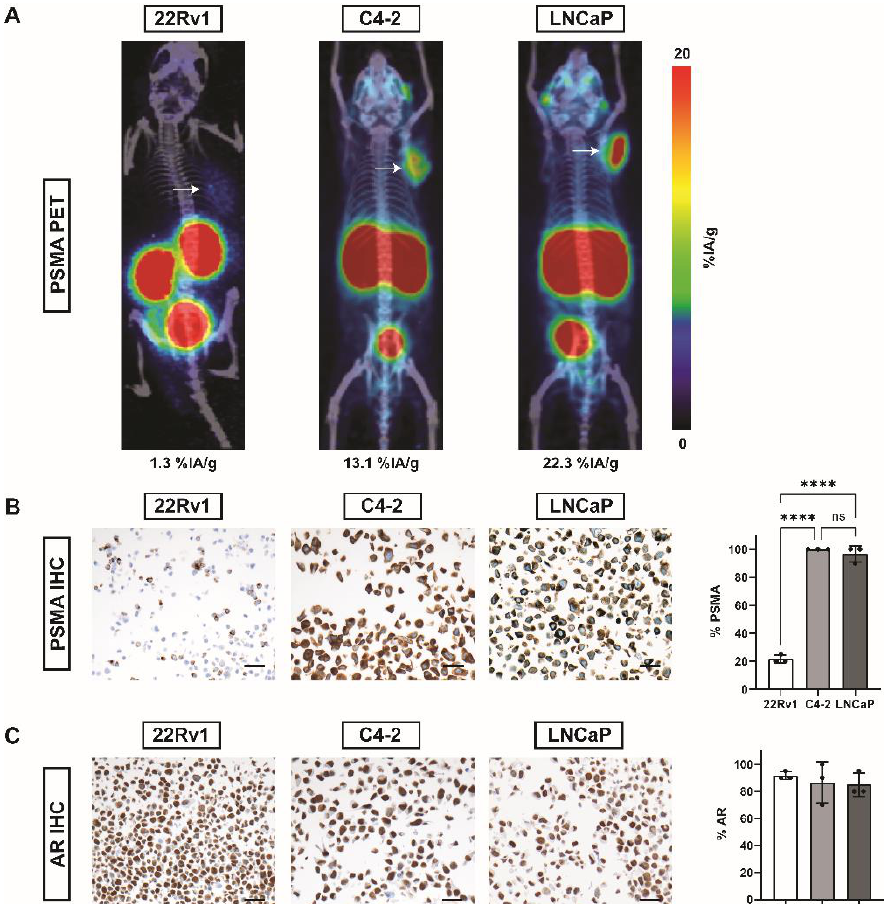
Figure 1. PSMA and AR in 22Rv1, C4-2, and LNCaP prostate cancer cell lines by PET and IHC. ( A ) Exemplary 68 Ga-PSMA-11-PET/CT maximum intensity projection (MIP) images of NOD/Scid mice bearing tumors (white arrows) of 22Rv1, C4-2, or LNCaP cell lines. Average tumor uptake (%IA/g) per gram tissue is stated below the image. ( B ) Representative images of PSMA IHC and bar plots for % positivity (mean ± SD, n = 3). ( C ) Representative images of AR IHC and bar plots for % positivity (mean ± SD, n = 3). Scale = 20 µm. Abbreviations : PSMA, prostate-specific membrane antigen; %IA/g, % injected activity per gram tissue; AR, androgen receptor. Statistics: ordinary one-way ANOVA with Sidak’s multiple comparisons test; **** p ≤ 0.0001; ns = non